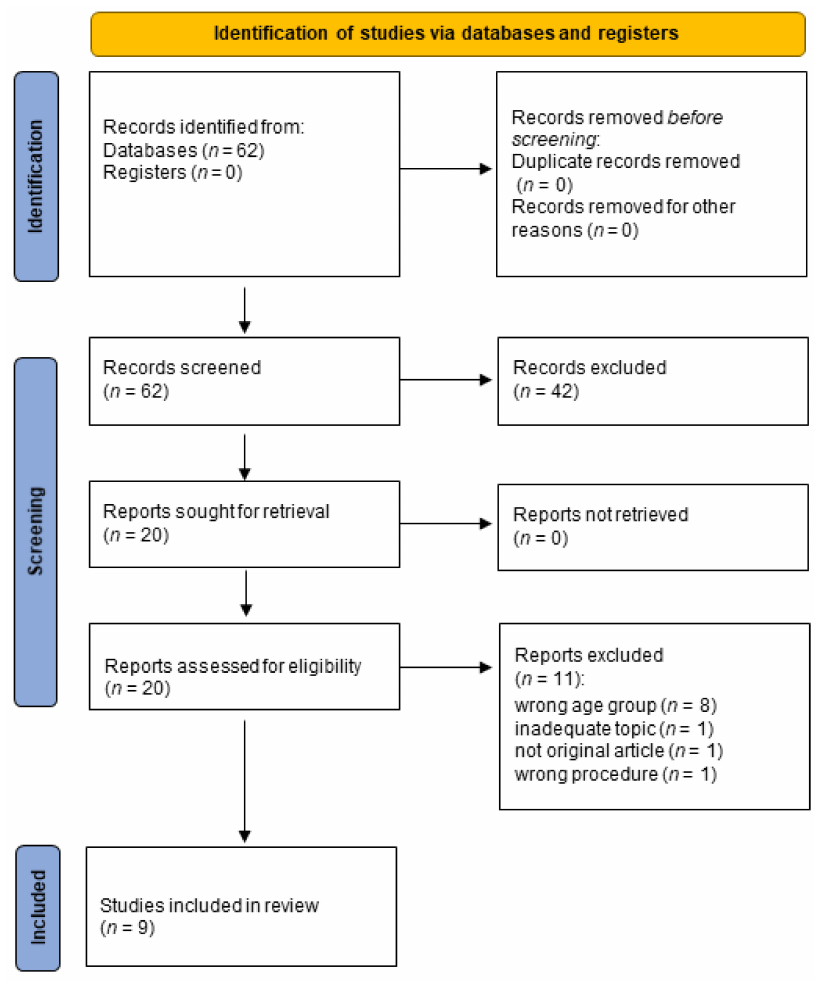
Figure 1. Study selection, following the PRISMA 2020 statement